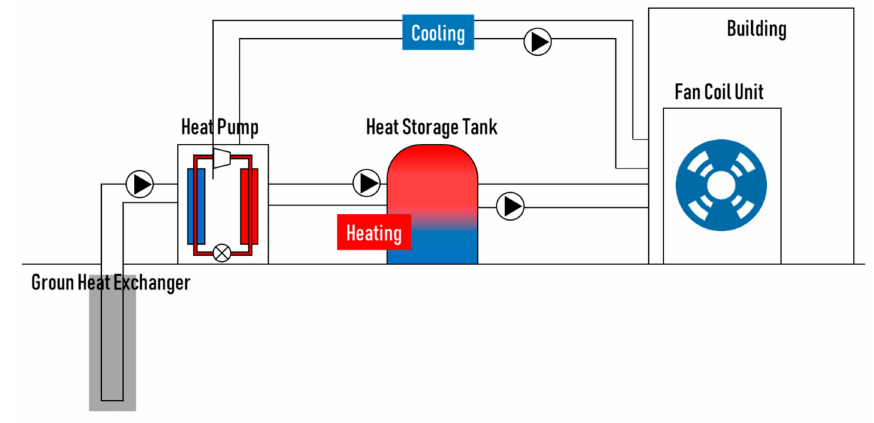
Figure 3. Ground source heat pump (GSHP) system schematic diagram.